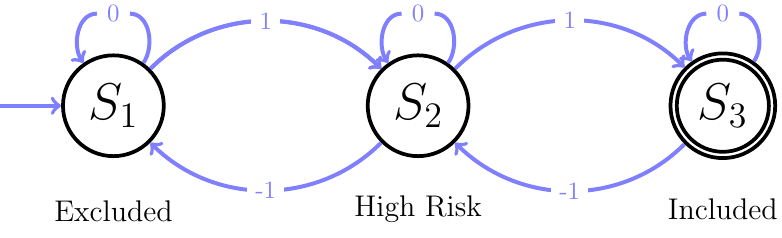
Figure 5: Example state